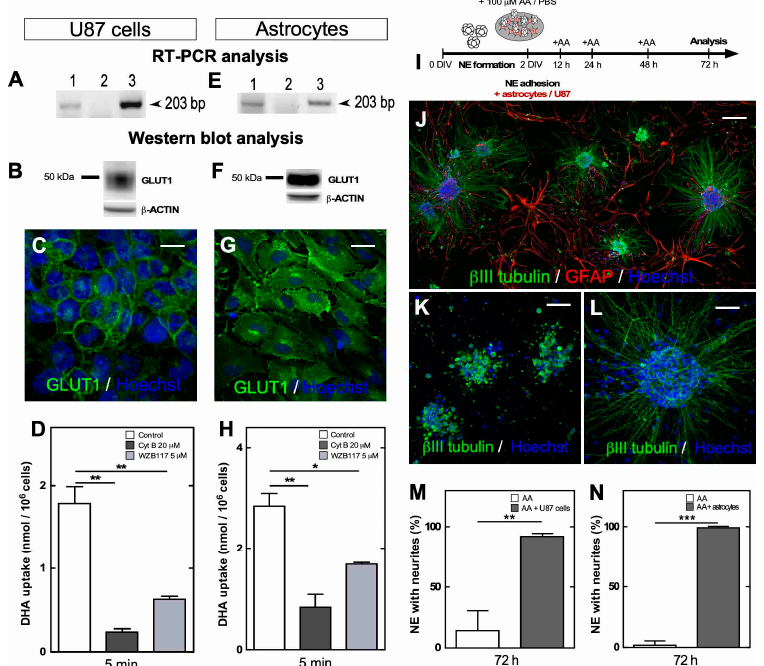
Figure 5. Vitamin C recycling using astrocytes, maintained neurite outgrowth under long-term AA treatment. ( A , E ) PCR analysis of GLUT1 mRNA. RNA extracts obtained from U87 cells ( A ) and cortical astrocytes (E)(line 1), negative RT-PCR control (line 2), and positive control using complete brain extract (line 3). ( B , F ) Western blot analysis of GLUT1 in U87 cell ( B ) and cortical astrocyte extracts ( F ). ( C , G ) Immunocytochemistry analysis of GLUT1 (green) in U87 cells ( C ) and astrocytes ( G ). Scale bar, 15 μ m. ( D , H ) Uptake of 100 μ M DHA for 5 min in the presence of 20 μ M Na + , cytochalasin B or WZB117 in U87 cells ( D ) and astrocytes ( H ). All data are representative of three separate experiments. Parametric ANOVA, followed by Tukey’s test, * p <0.05; ** p <0.01. ( I ) Experimental model of mixed cultures of NEs with U87 cells or cortical astrocytes at 7 DIV, which were treated with AA for 72 h. ( J , L ) Immunocytochemical and confocal tile-scan microscopy analyses of β III tubulin (green), GFAP (red) and nuclear staining with Hoechst, in mixed NEs cultured with cortical astrocytes. Scale bar, 100 µ m. High-power image of NEs ( L ). Scale bar, 30 µ m. ( K ) Immunocytochemical and confocal microscopy analyses of β III tubulin (green) and nuclear staining with Hoechst, in control NEs treated with AA for 72 h in the absence of astrocytes. Scale bar, 30 µ m. ( M , N ) Total NEs with neurites generated at 72 h in mixed cultures of NEs with U87 cells ( M ) or cortical astrocytes ( N ). All data are representative of three separate experiments. Parametric Student’s t -test was used for statistical analysis, ** p < 0.01; *** p <